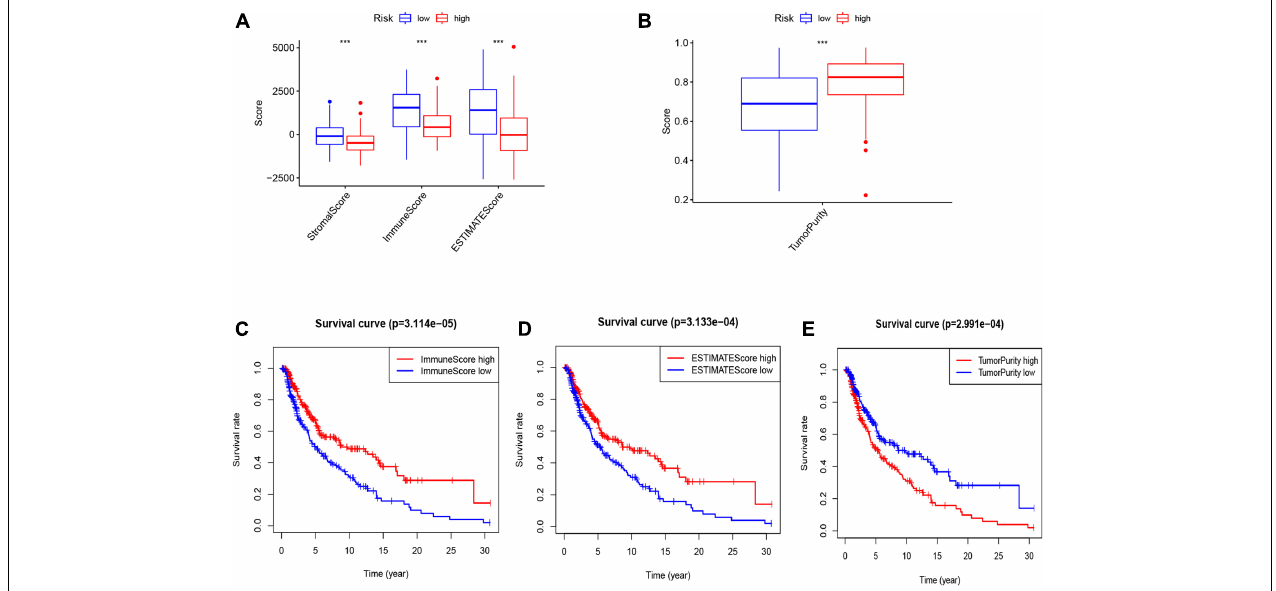
FIGURE 8 | The score of stromal, immune, ESTIMATE (A) , and tumor purity (B) in two risk groups (high vs. low). K–M curve of OS between high and low immune, ESTIMATE and tumor purity (C–E) .